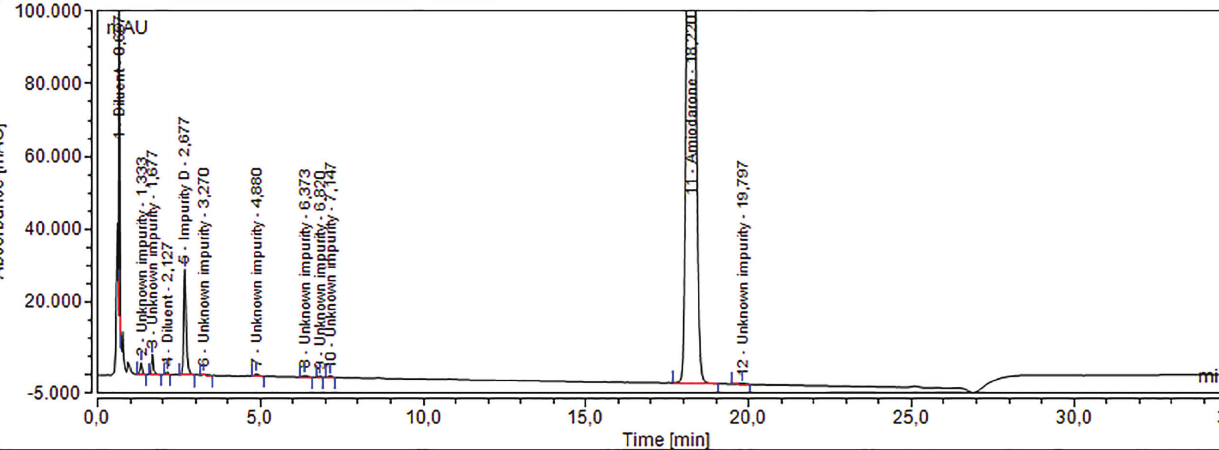
FIGURE 3 - Representative chromatogram of amiodarone hydrochloride tablets after degradation by alkaline